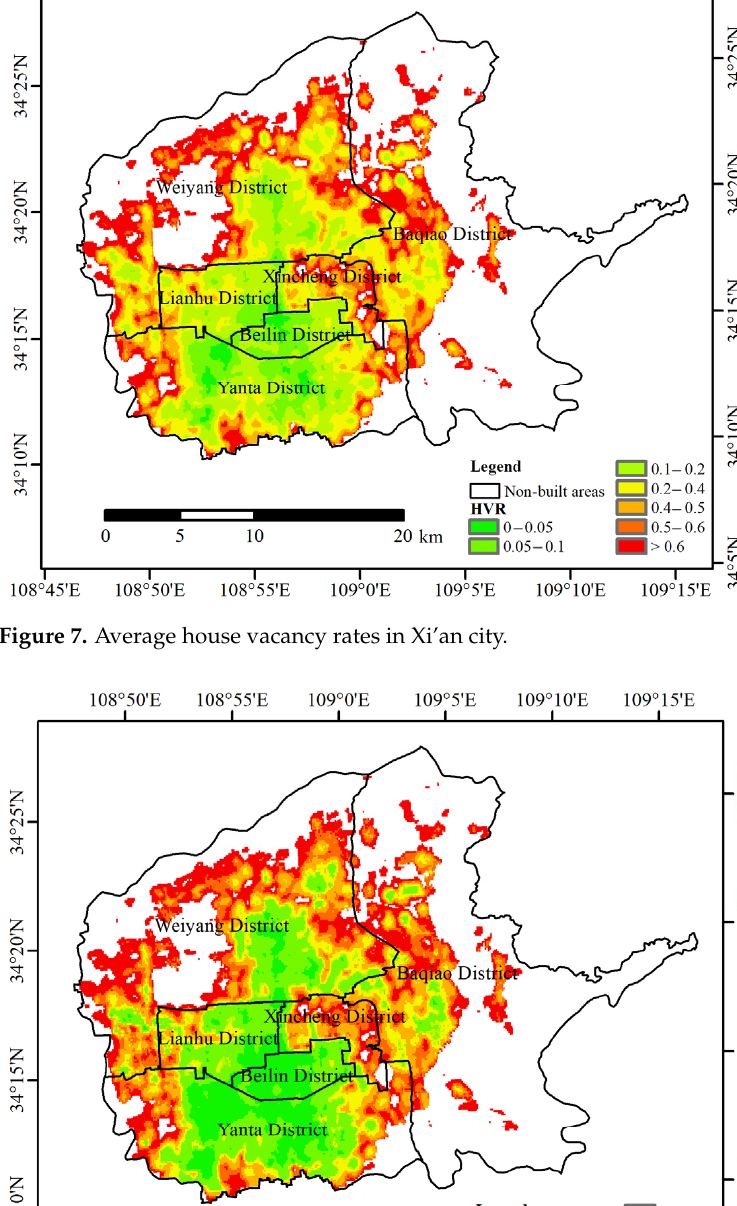
Figure 9. House vacancy rates at the district scale. As the iconic old town of Xi’an city, The average HVR of Beilin District was 0.043. Beilin District is named after the well-known “Forest of Steles in Xi’an”, at home and abroad, which is an urban area with a developed culture and education system, cultural relics and scenic spots, strong scientific and technological projects, and a prosperous mar- ket economy. There are more employment opportunities in urban areas and the various basic service facilities are of high quality; thus, the HVR in Beilin District was lower than that in other urban areas.